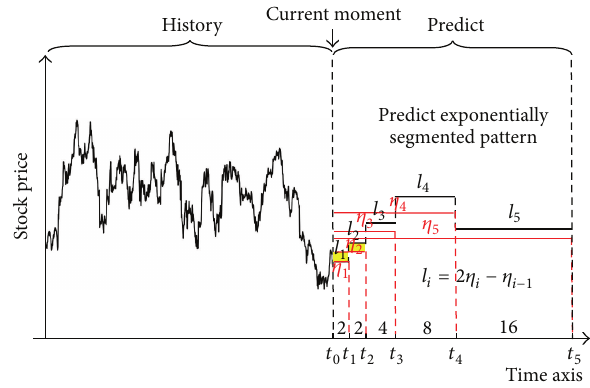
Figure 1: Illustration of ESP and the relation of l and 𝜂